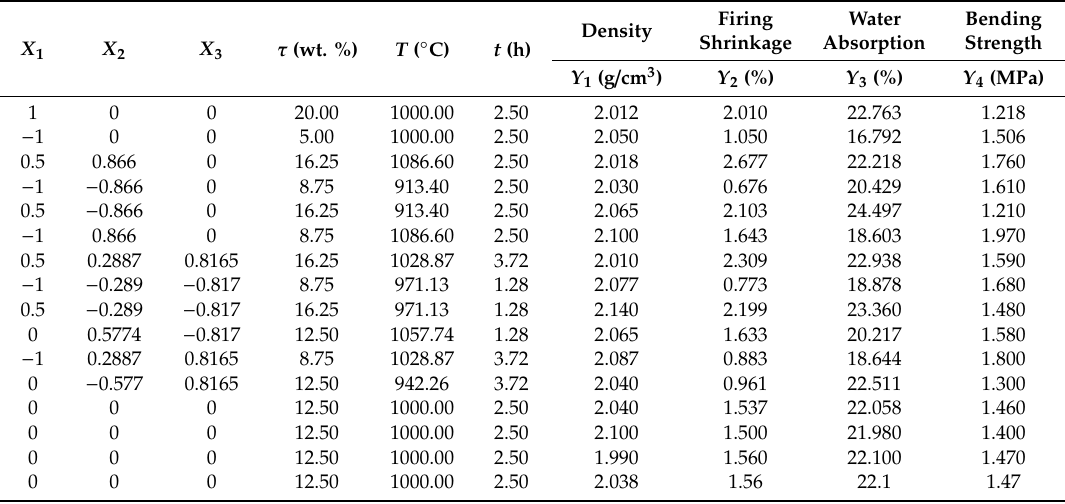
Table 2. Experimental design matrix (Doehlert) and measured values of the studied properties. Y 1 : density; Y 2 : firing shrinkage; Y 3 : water absorption; Y 4 : bending